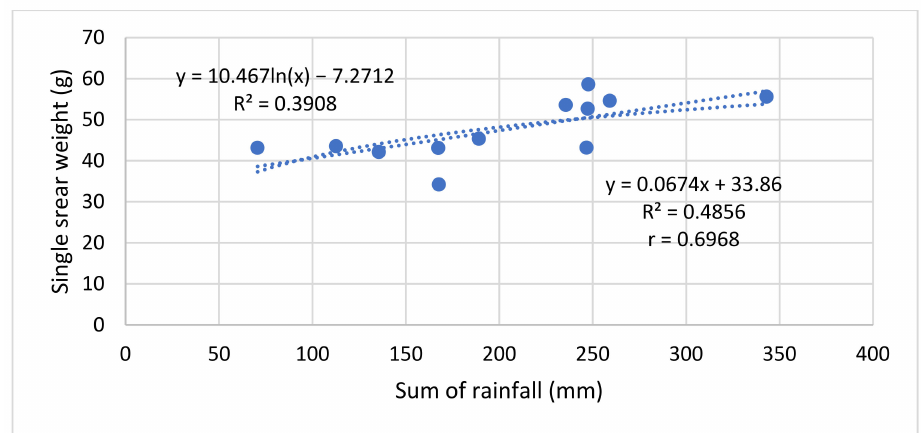
Figure 4. Relationship between sum of rainfall and irrigation rates in July–August and single-spear weight of ‘Ramada’.